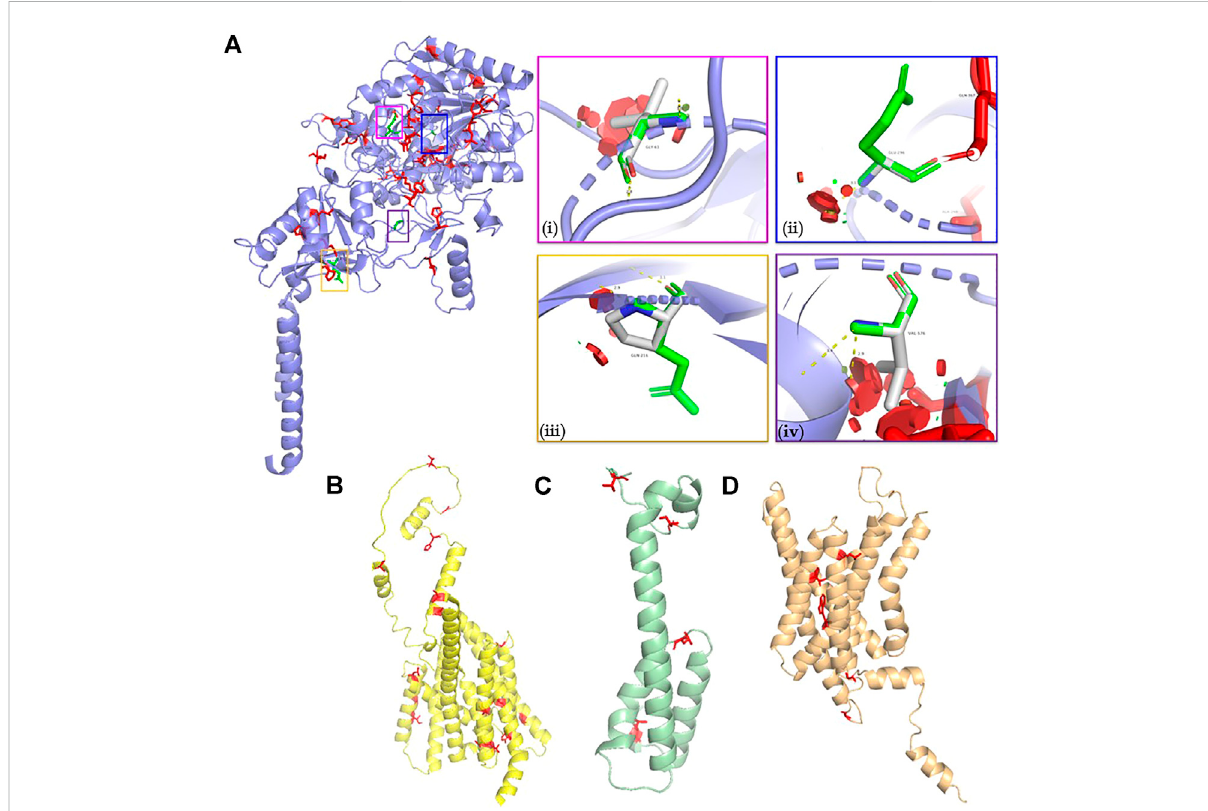
FIGURE 4 Molecular models of (A) NCSTN (B) PSEN (C) PSENEN and (D) APH1A proteins. Structurally deleterious residues are highlighted as red ball and stick residues. The structurally damaging NCSTN missense variants described in HS are illustrated in vignettes (i) p. Gly61Val (ii) p. Glu296Gly (iii) p.Gln216Pro, and (iv)p.Gly576Val. The p.Gly61Valtriggersadisallowedphi/psiangle andreplaces aburiedglycine residue.The p.Gly296Glyvariant also triggers a disallowed phi/psi angle. Finally, the p. Gly296Gly variant replaces a burred charged residue with an uncharged residue. It also leads to expansion of the cavity volume by 139.9 (cid:1)